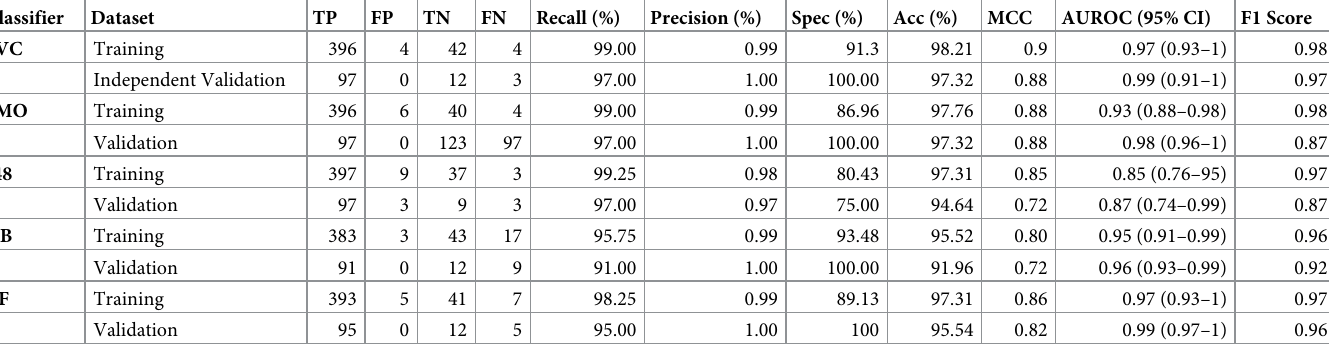
Table 6. The performance measures of prediction models developed based on 5-protein coding transcripts (THCA-CN-F) feature set selected by F_ANOVA feature selection method for discriminating cancer and normal patients on training and independent validation dataset.